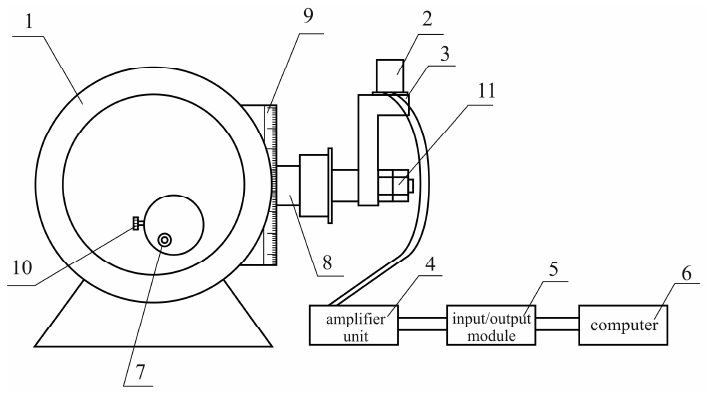
Figure 9. Experimental device for SE calibration 1—optical dividing head; 2—SE; 3—bracket; 4—amplifier unit; 5—input/output module; 6—PC; 7—10: knobs; 8—axle; 9—readout scale; and 11—mounting nuts.